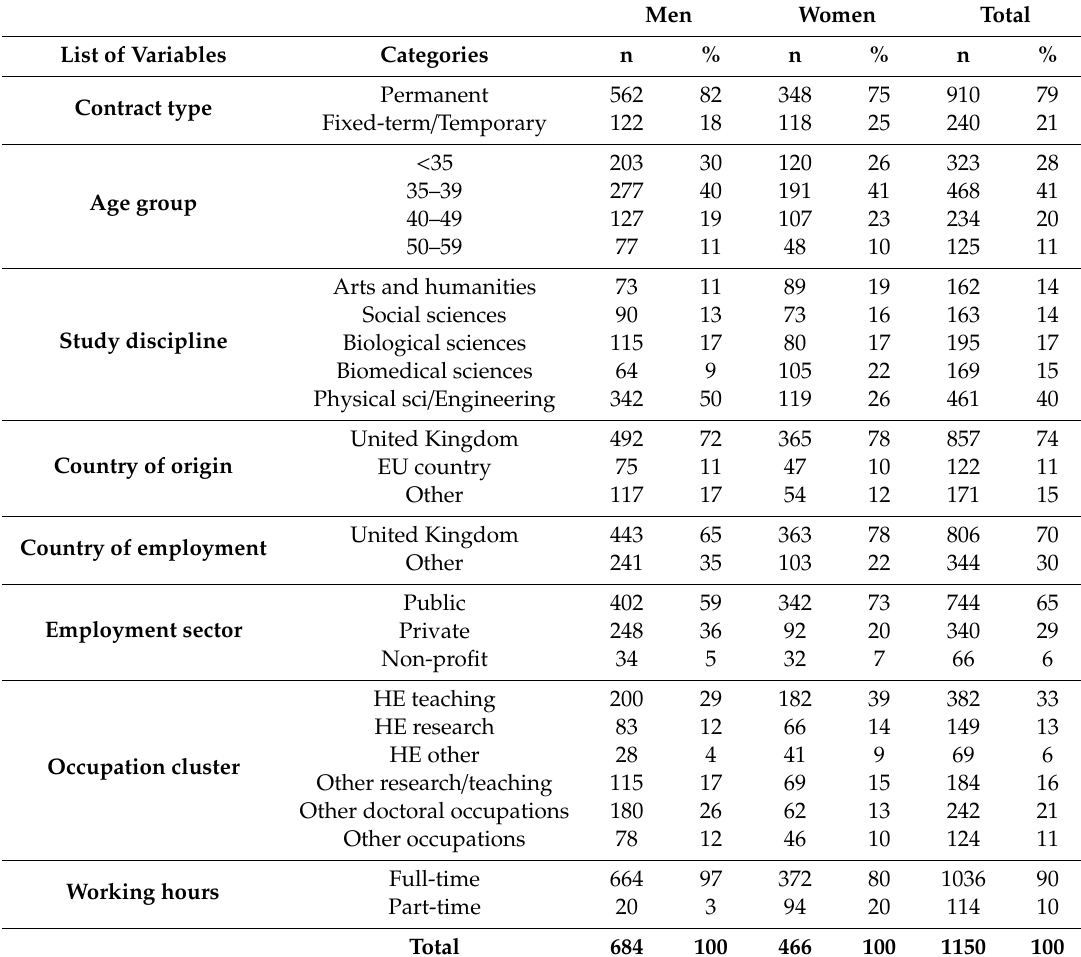
Table 1. Sample characteristics of doctoral graduates in 2013 (seven to nine years